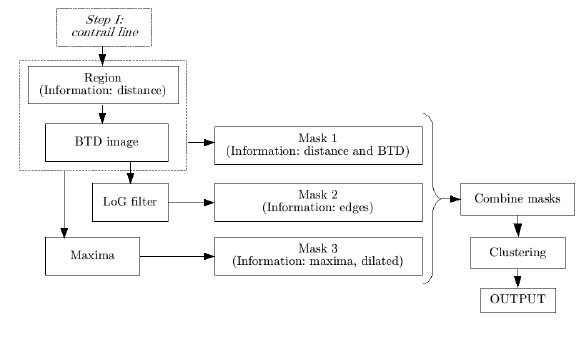
Fig. 9. Test 1–Test 5: Background, BTD image (in K). Enclosed in yellow, guide points found in each test. Bottom, right: Output of Step I, line (white) that corresponds to the contrail tracked by ACTA. Table 3 shows the process in detail. Location: Over the Mediterranean between Sicily and Tunisia. Date: 19 June 2009 09:45UTC.